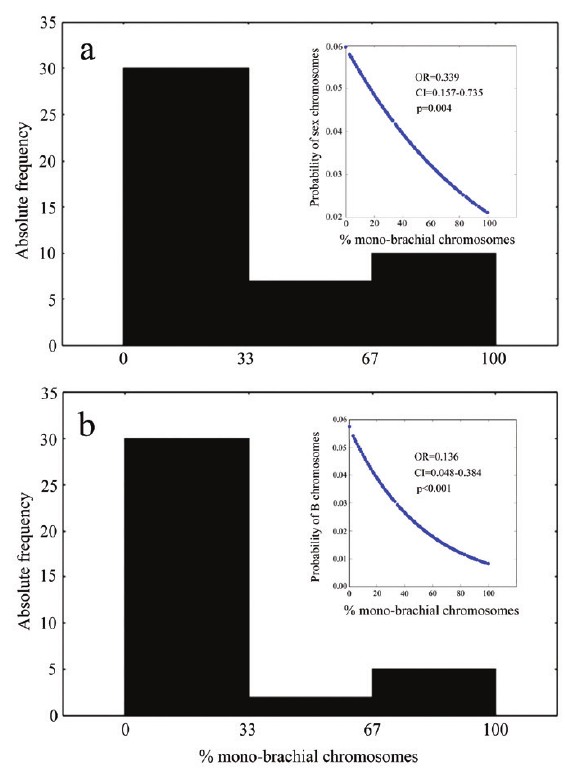
Figure 2 - Absolute frequencies of karyotypes of Actinopterygii species with (a) sex chromosome systems and (b) B chromosomes distributed into classes based on the percentage of mono-brachial chromosomes. The logistic regression predicting sex and Bs chromosomes and percentage of mono-brachial chromosomes was statistically significant (p<0.001 and p=0.004). Both sex and Bs chromosomes are more likely to occur in karyotypes with a large number of bi-brachial chromosomes. OR=odds ratio; CI=95% confidence